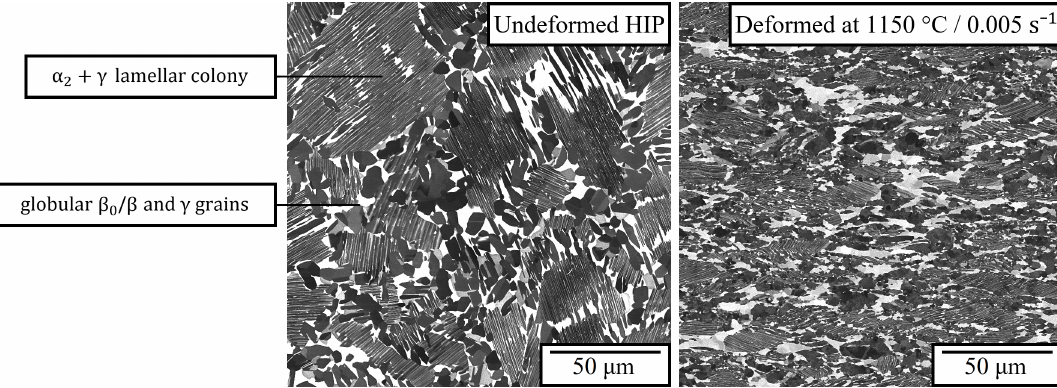
Figure 4. SEM image of undeformed HIPed TNM-B1 and hot formed TNM-B1 at 1150 ◦ C and 0.005 s –1 , consisting of the ordered phases γ -TiAl (dark contrast), α 2 -Ti 3 Al (gray contrast) and β / β 0 -TiAl (bright contrast). The loading direction is along the